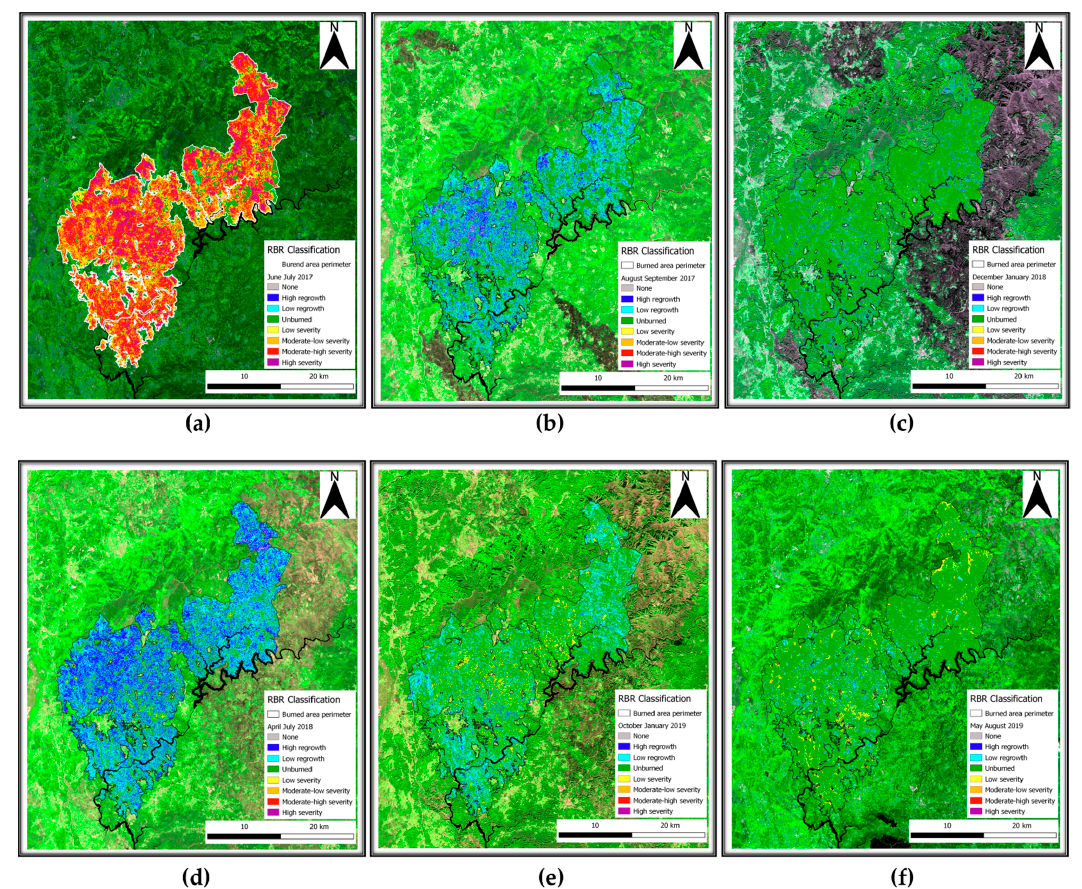
Figure 6. Sentinel-2 RBR computed index severity classes and area represented over the scene. ( a ) June–July 2017 couplet; ( b ) August–September 2017 couplet; ( c ) December–January 2018 couplet; ( d ) April–July 2018 couplet; ( e ) October–January 2019 couplet; ( f ) May–August 2019 couplet. 5-8A-5 color composite.